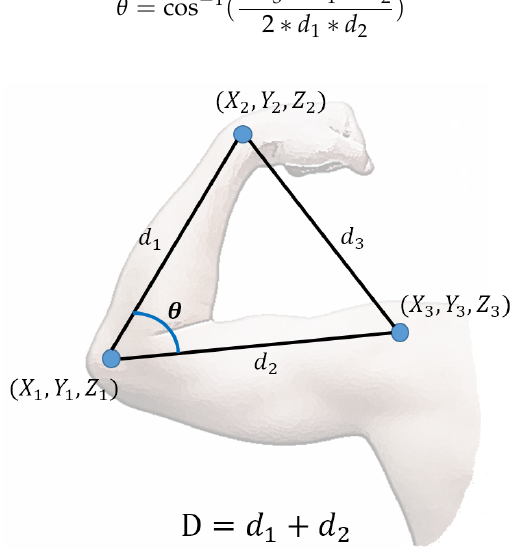
Figure 4. Parameters to calculate the articulation angle of any